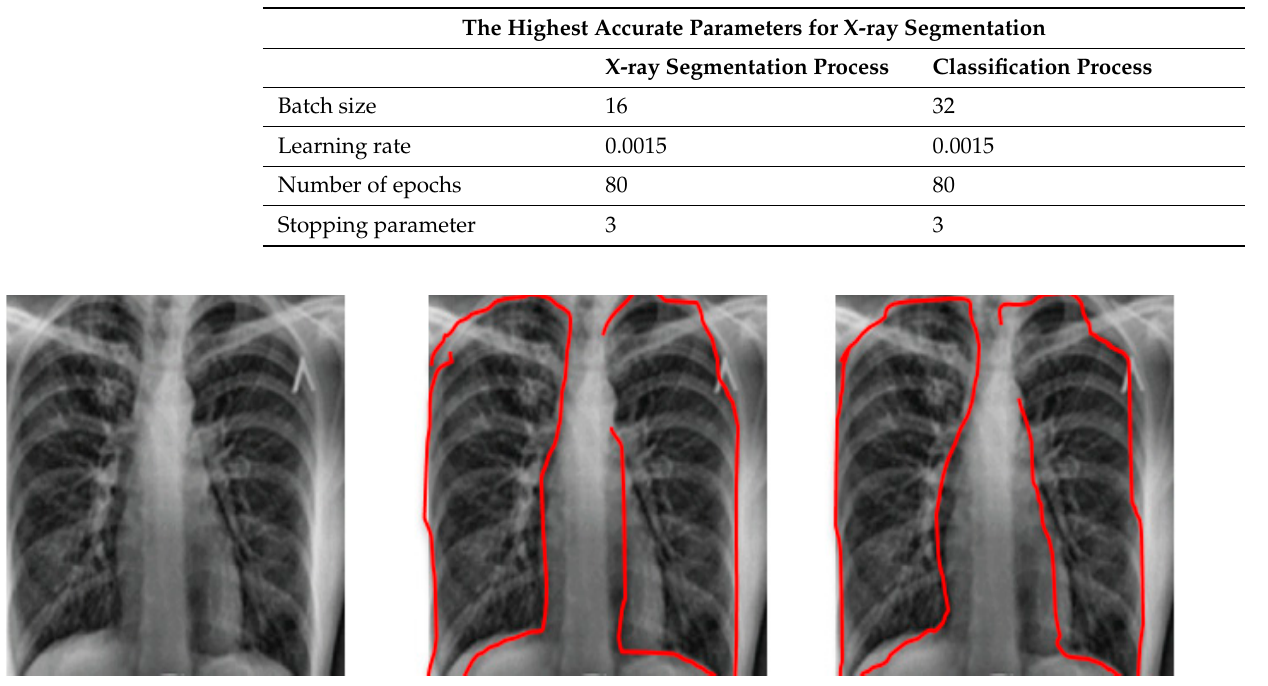
Figure 5. X-ray radiography, with segmented Pulmonary original BoxENet and Segmented Pulmo- nary Improved BoxENet. monary Improved